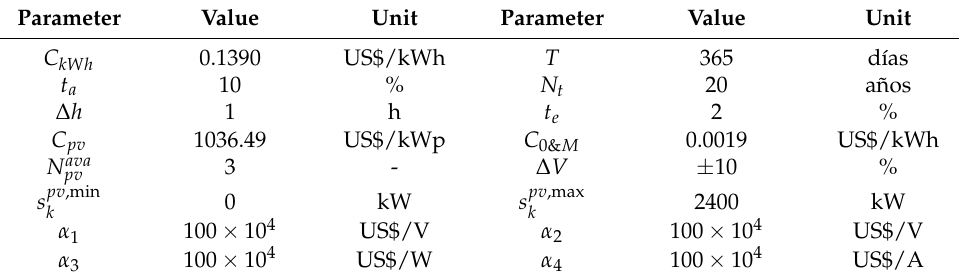
Table 1. Parametric information regarding the objective function calculation.